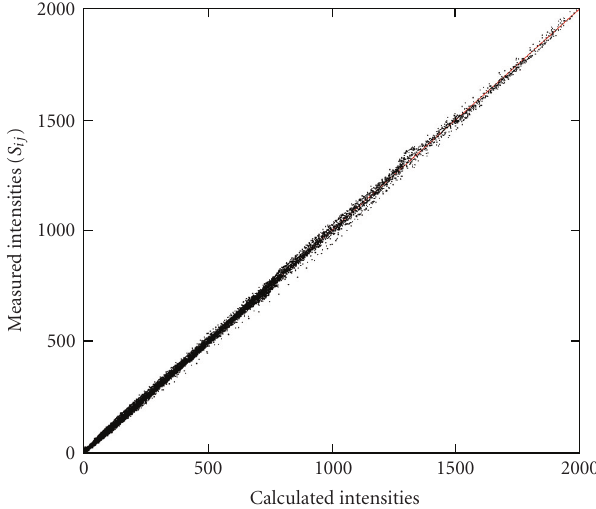
Figure 4: Comparison of reconstructed spectral intensities with experimental intensities. Experimental intensities from 52 fluo- rescence spectra are plotted against calculated intensities. The calculation is based on an equation, Equation (4), containing the first two principal vectors. The plot contains 52 × 2048 points. Each measured spectra was shifted to get zero average intensity at the first 50